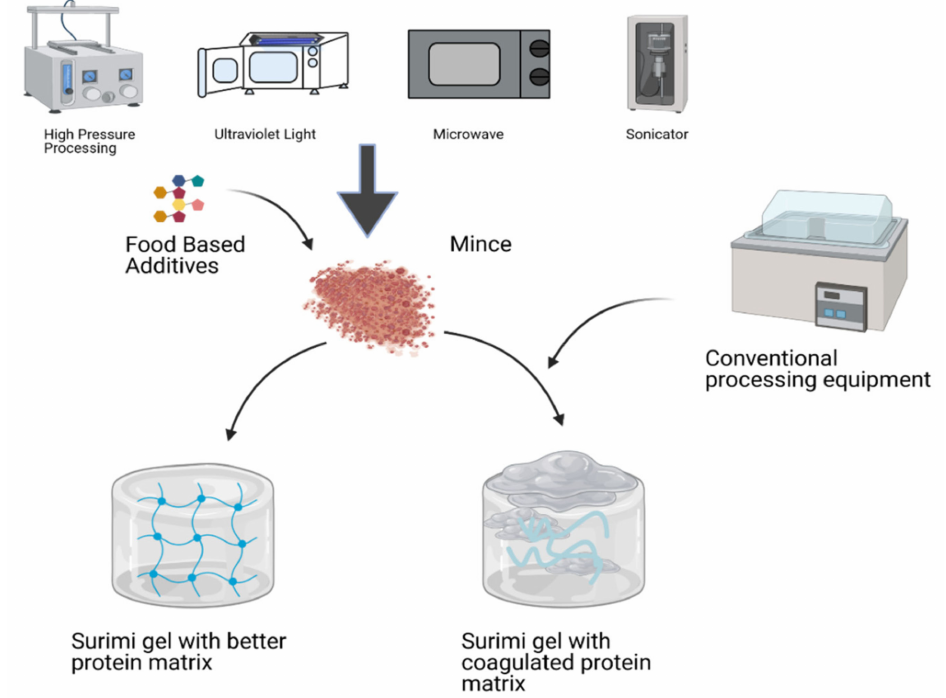
Figure 2. Surimi gel prepared with non-conventional and conventional techniques. Non-conventional techniques show a more stable and well-established gel network than conventional processing